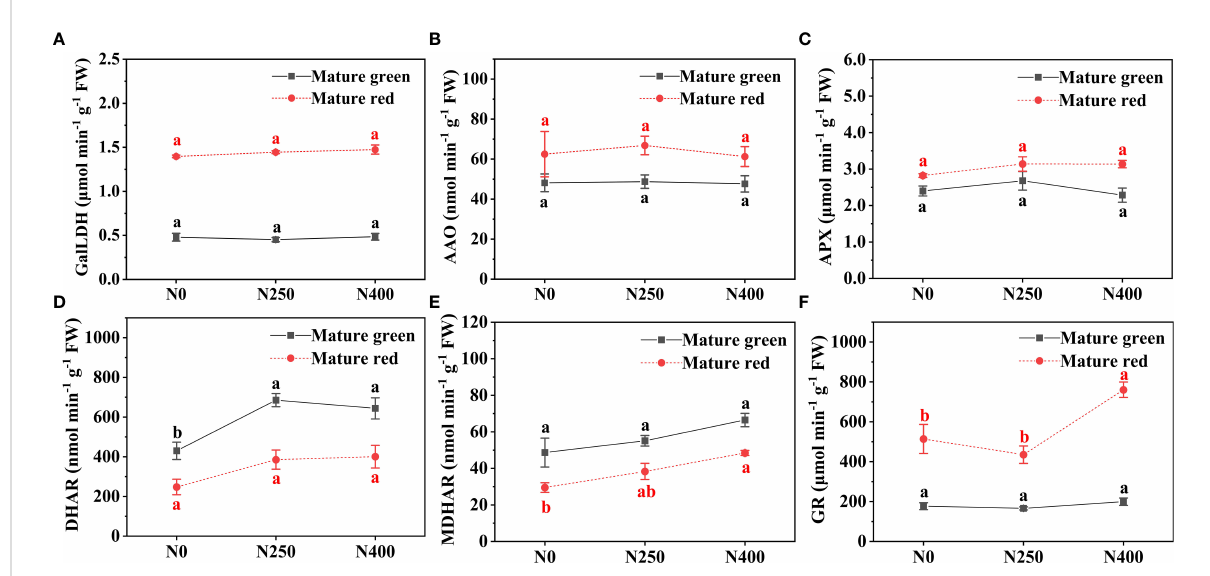
FIGURE 2 Enzyme activity of GalLDH (A) , AAO (B) , APX (C) , DHAR (D) , MDHAR (E) and GR (F) in the pericarp of pepper fruits at mature green and red stage produced under different N levels. Values (means ± SE, n = 4) followed by different letters indicate signi fi cant difference between N levels at the same growth stage at P < 0.05 according to the Duncan ’ s multiple range test.